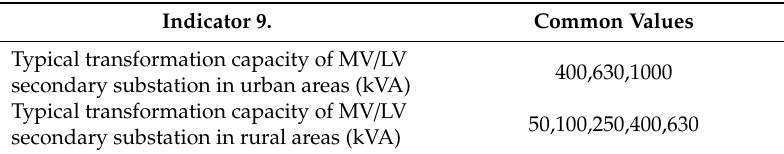
Table 2. Typical transformation capacity